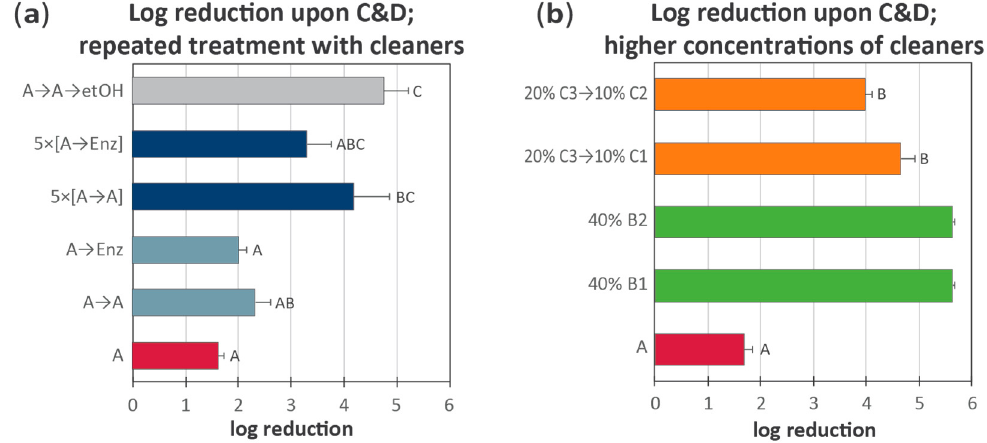
Figure 4. Tolerance of biofilms with reinforced cleaning protocols. Biofilms were allowed to develop for 4 days, and coupons were then cleaned with agent A followed by disinfection with 1.5% PAA for three consecutive days. On day 7, coupons were subjected to di ff erent treatment protocols, and the amount of L. monocytogenes remaining on coupons after treatment was compared with the number of bacteria present on the day 7 coupons that were subjected only to rinsing in H 2 O. For details on protocols, see the main text and Figure 1c,d. ( a ) Bacterial reductions obtained after biofilm treatment with reinforced cleaning and repeated C&D steps ( b ) Bacterial reductions obtained after biofilm treatment with high dosages of chemical cleaning agents. Experiments in ( a ) and ( b ) were performed at the same time, and the results for the control treatment using standard C&D treatment with cleaning agent A (column A, in red) is shown in both figures. The average CFU per coupon for coupons rinsed in H 2 O only was 1.8 × 10 7 CFU coupon − 1 , and the detection limit was 5.6 log reductions. Results are based on ( a ) three and ( b ) two biological replicates, each with parallel coupons. Mean values and standard errors of the means are shown, with di ff erent letters indicating statistically di ff erent e ff ect of treatments (confidence level 95%); except in ( b ), where treatments with agents B1 and B2 reached the detection limit, and therefore, significance was not calculated.